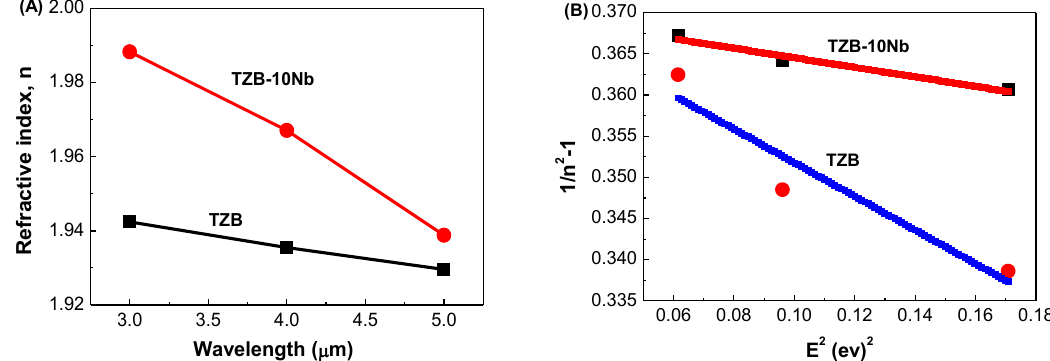
Figure 4. ( A ) Variation of refractive index in dependence of wavelength for TZB and TZB–10Nb glasses. ( B ) Variation of refractive index with photon energy, obtained using Wemple’s approximation for the experimental data of TZB and TZB–10Nb glasses. The red and blue curves indicate the two terms Sellmeier equation fit to the data.